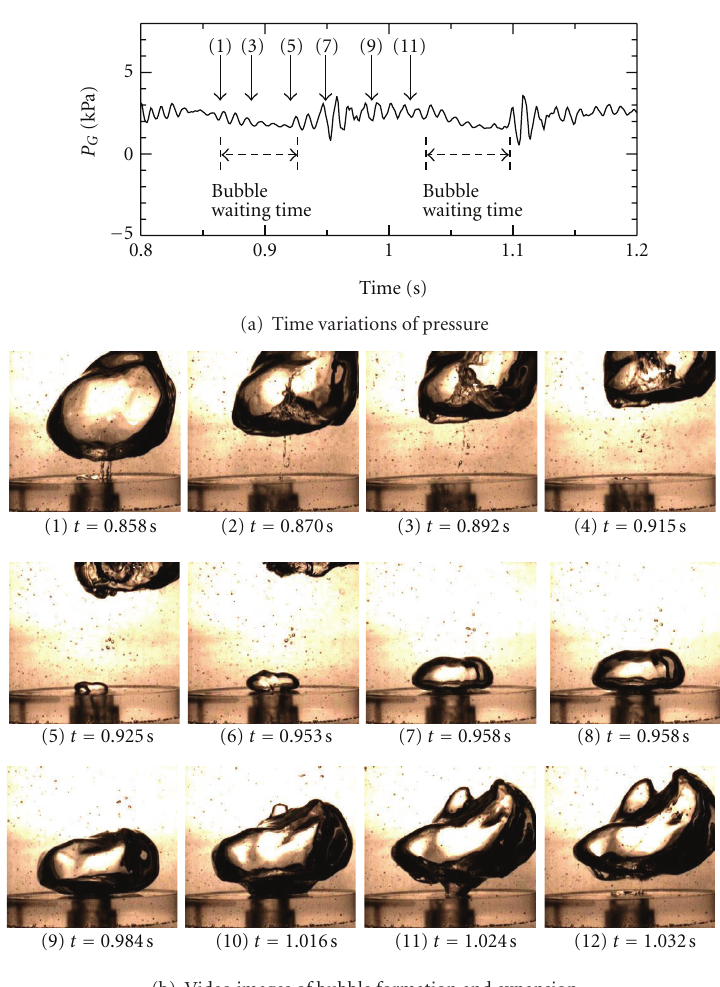
Figure 6: Time variations of pressure at the upper entry of the tube (PT1) and bubble formation and expansion process including waiting = 0 . 41, indicated as (c) in Figure time (tube diameter D = 20 mm, j ∗ 0 . 5 g